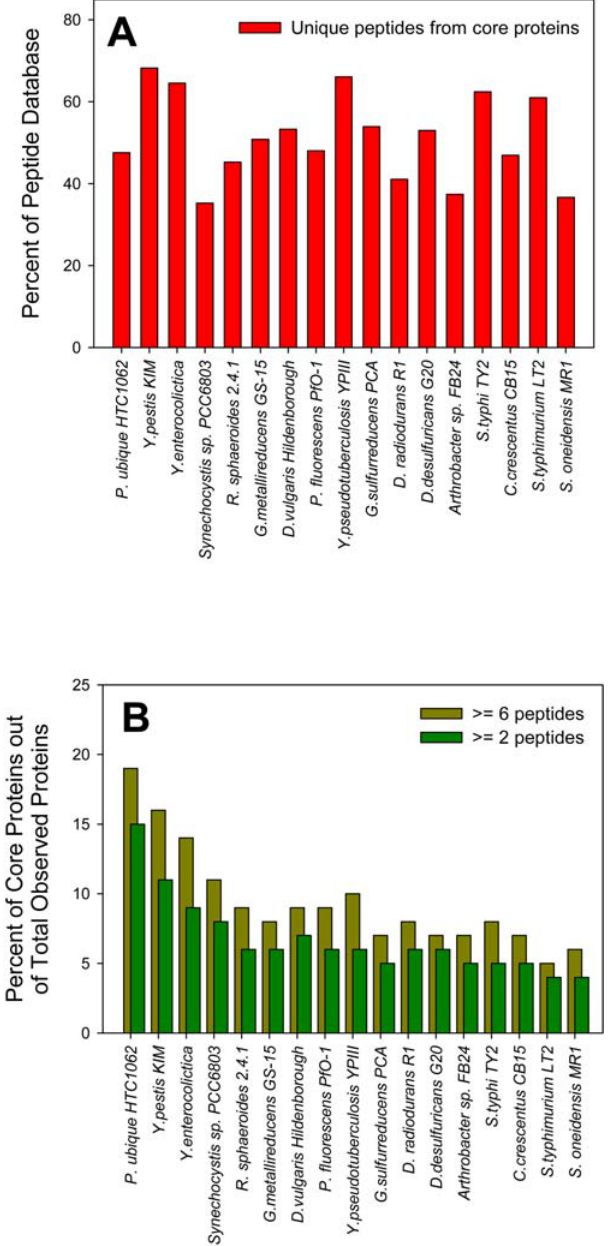
Figure 3. The analysis of peptides and their corresponding proteins identified within each bacterium ’ s database of observed peptides. Organisms on the x-axis are sorted by proteome size (increasing). A) The percent of each proteome composed of peptides identifying core proteins predicted by the core genome. A significant percentage of each proteome was composed of these peptides, which suggests that they are regularly observed. B) The percentage of core proteins observed out of the total number of proteins identified by peptides within each proteome. As the number of peptides required to identify a protein increased (from 2 to 6 peptides), the percentage of core proteins out of the total number of observed proteins also increased.